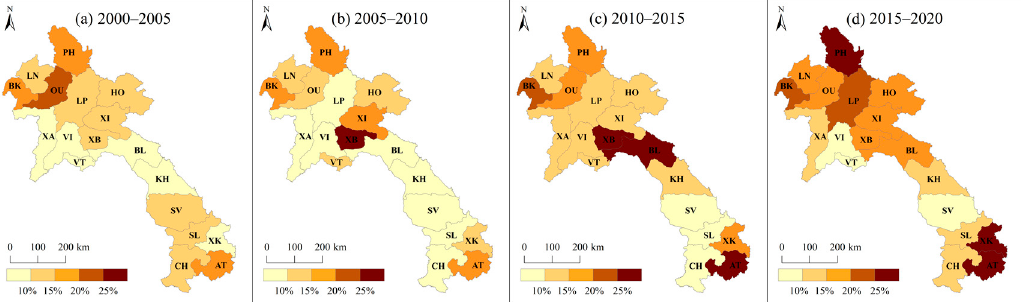
Figure 4. The spatial distribution map of integrated dynamic degree of LUCC in Laos.